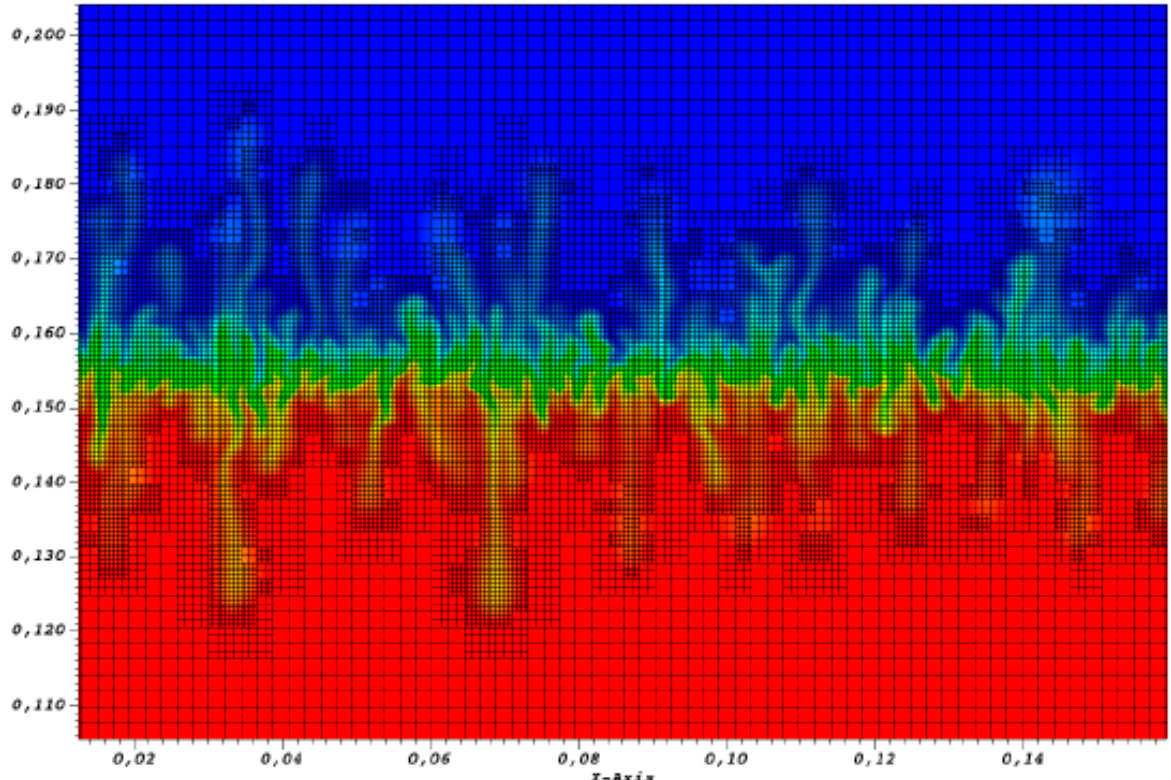
Figure 2. Predicted normalized sucrose concentration for R ρ = 1.4 at t = 166 min. The normalized concentration ranges from zero (red) to one (dark blue).